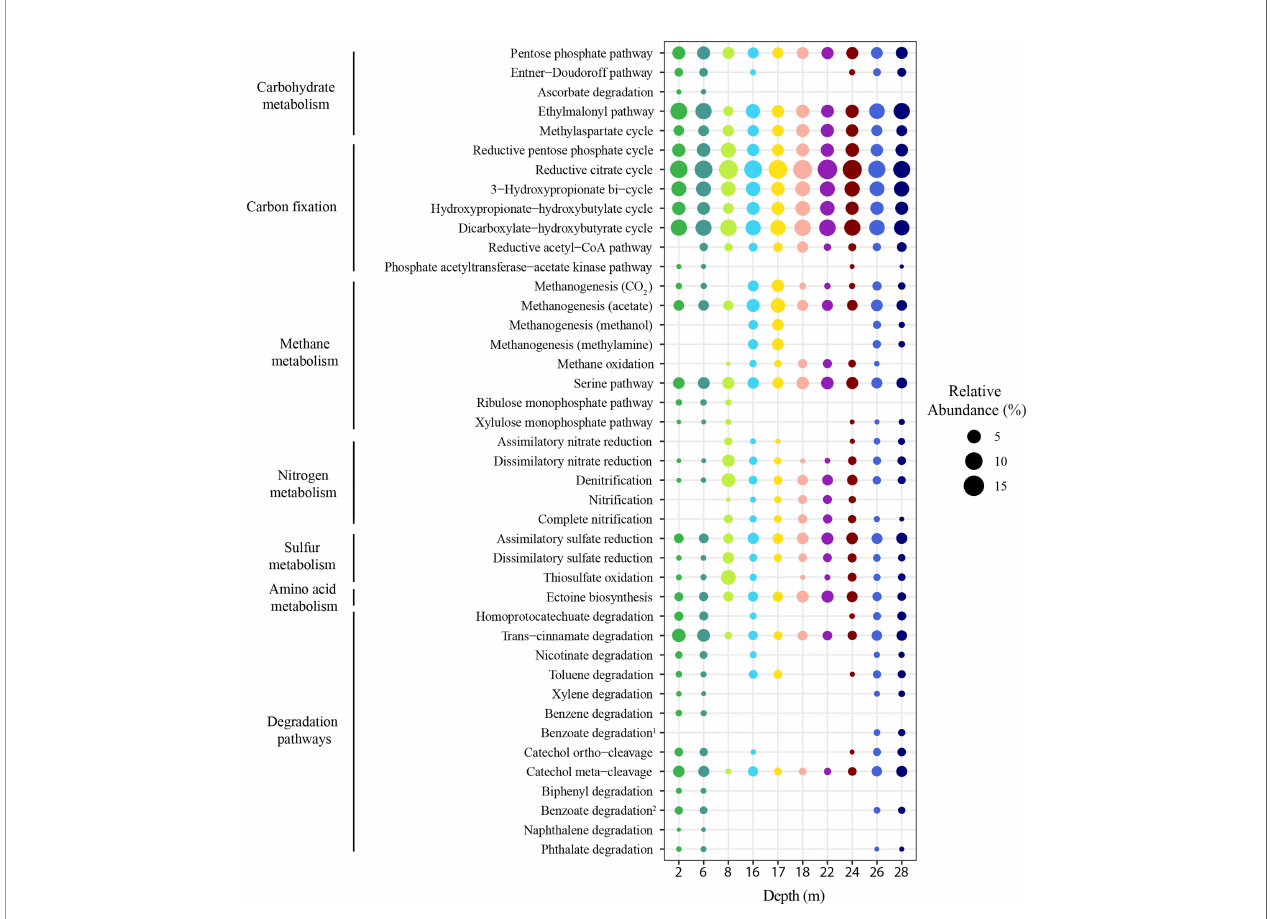
FIGURE 7 | Predicted metabolic potential of the strati fi ed microbial communities occurring in the Bundera Sinkhole. Dot plot displaying the Tax4Fun2 predicted functional pro fi les for each sampled depth as relative abundance of predicted microbial metabolisms (Reference KEGG pathway: map01120). Replicates were averaged to show one representative value per depth with colours used to represent depths as used in other fi gures. Benzoate degradation 1 represents the degradation of benzoate to methylcatechol and Benzoate degradation 2 represents the degradation of benzoate to